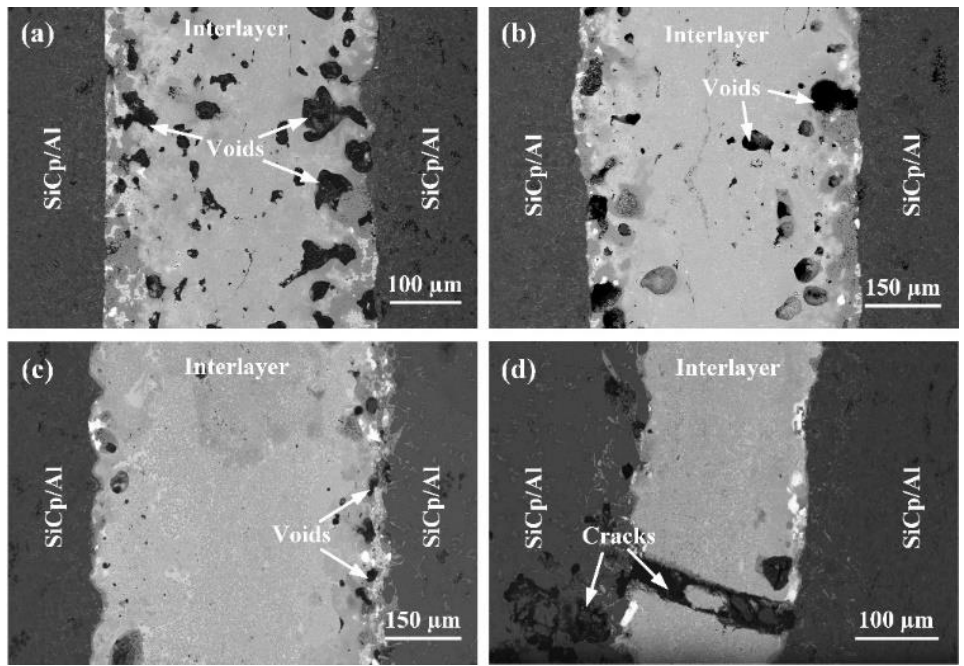
Figure 11. Microstructures of the joints bonded under different pressures. ( a ) 1.5 MPa; ( b ) 2 MPa; ( c ) 3 MPa; ( d ) 4 MPa.